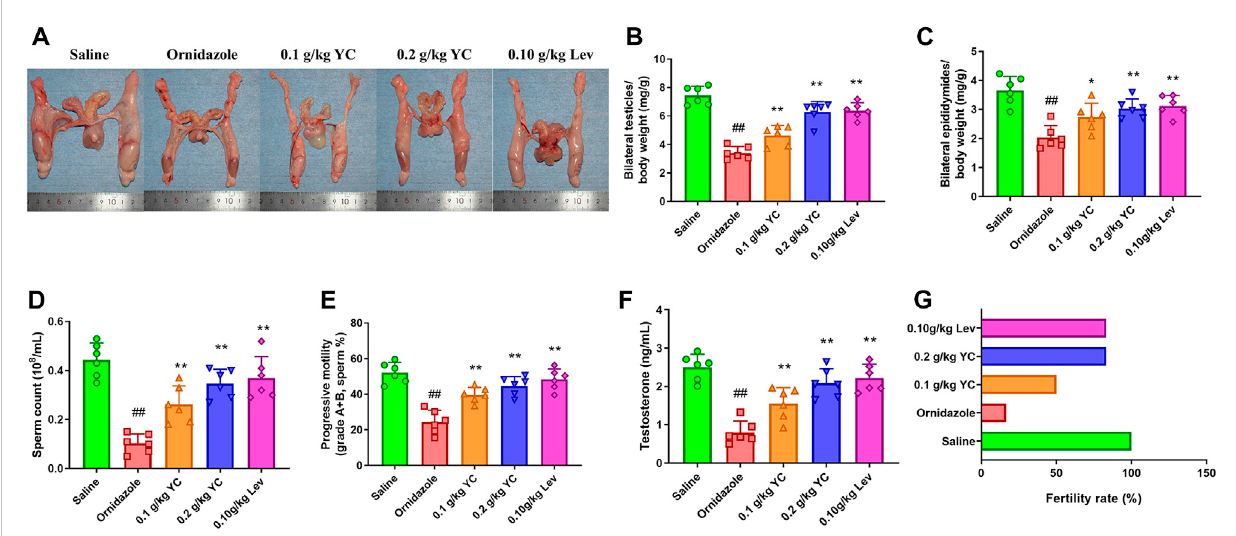
FIGURE 2 Effects of YC on oligoasthenozoospermia in rats exposed to ornidazole. (A) Characteristics of reproductive organs. (B) Relative weights of bilateral testicles. (C) Relativeweightsofbilateralepididymides. (D,E) Spermconcentrationandprogressivemotilityintheepididymis. (F) Levelsoftestosteronein the serum. (G) The fertility rate in percentages. Values are shown as averages ± SD (n = 6). ## p < 0.01 versus Saline group; * p < 0.05, ** p < 0.01 versus Ornidazole group.